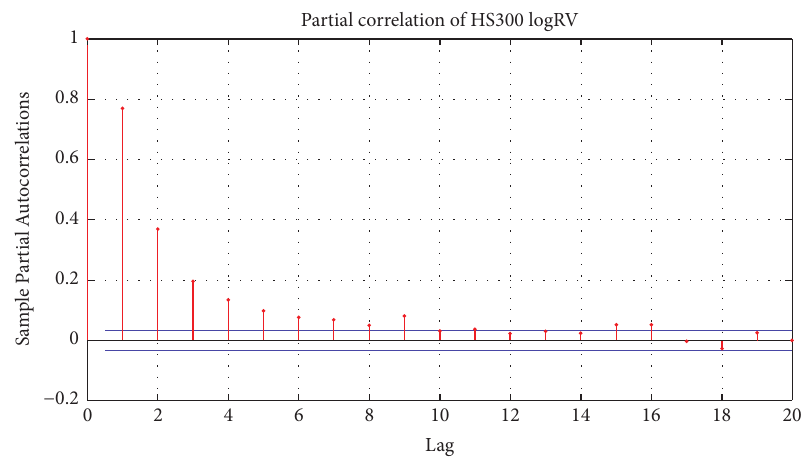
Figure 3: Partial autocorrelation coefficient of logarithmic realized volatility of CSI 300 index.